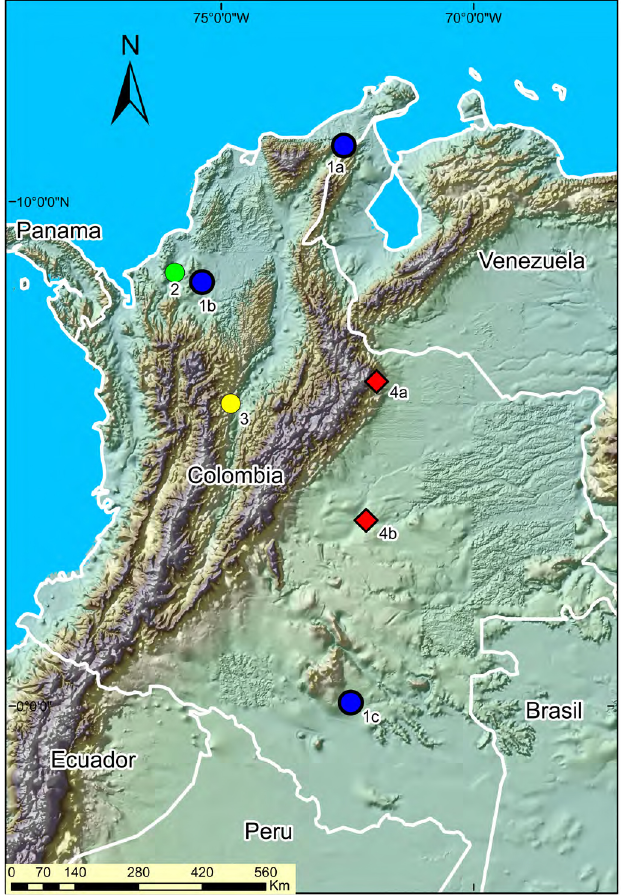
Glyphonycteris silvestris G. daviesi G. sylvestris and